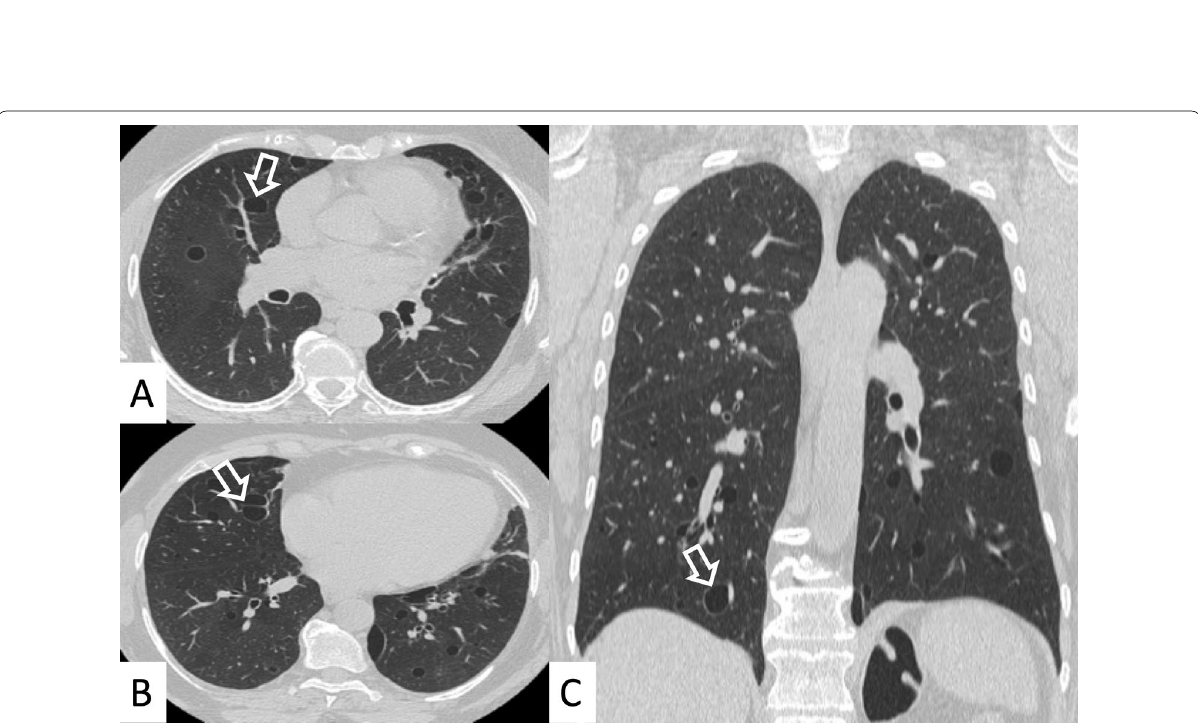
Fig. 26 Typical peribronchovascular locations of cysts in a female patient with SS. Cysts—sharply demarcated and thin-walled—are distributed along peribronchovascular structures (white empty arrows in A – C ); they may be not associated with other pulmonary